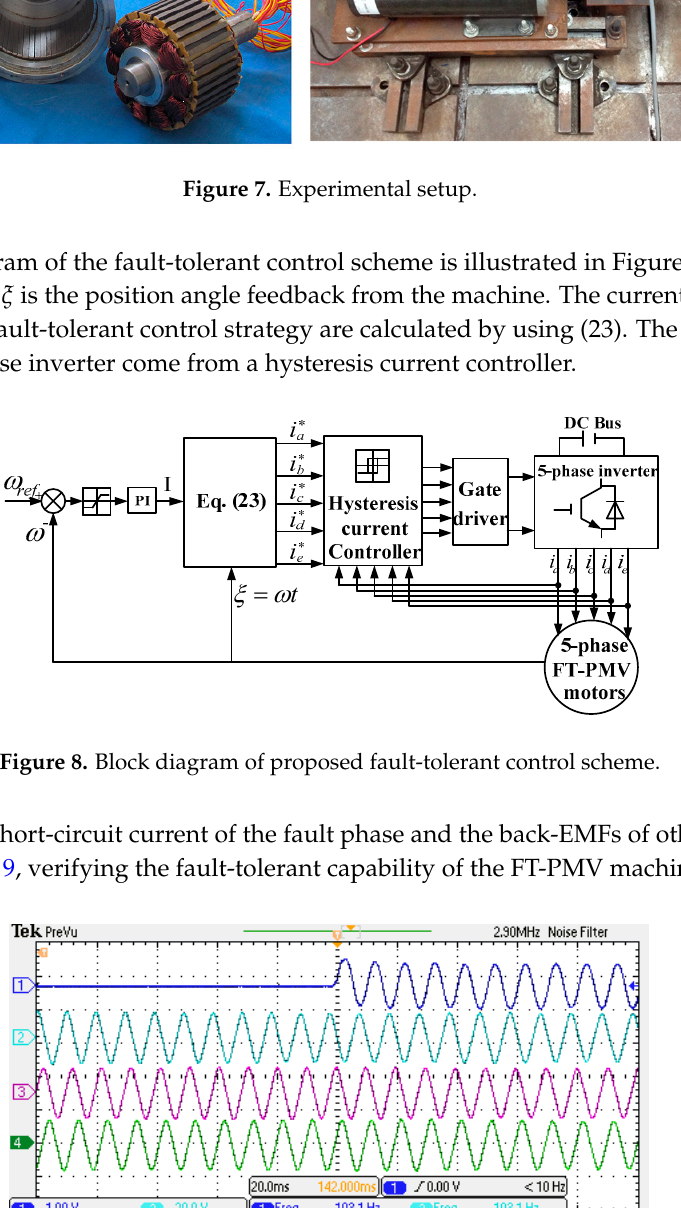
4) (10 ms/div, 10 A/div, 20 V/div).